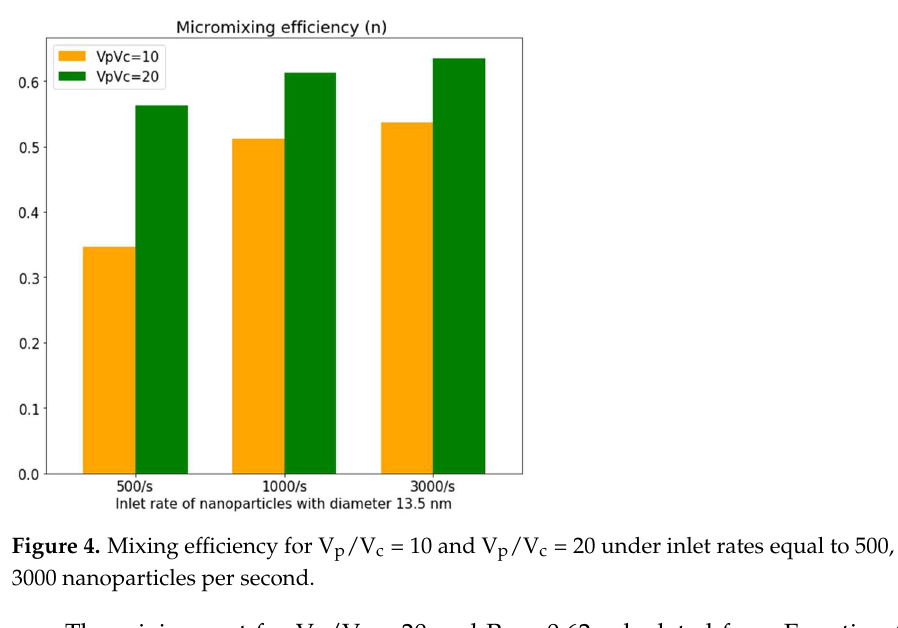
Figure 4. Mixing efficiency for V p /V c = 10 and V p /V c = 20 under inlet rates equal to 500, 1000, and 3000 nanoparticles per second.